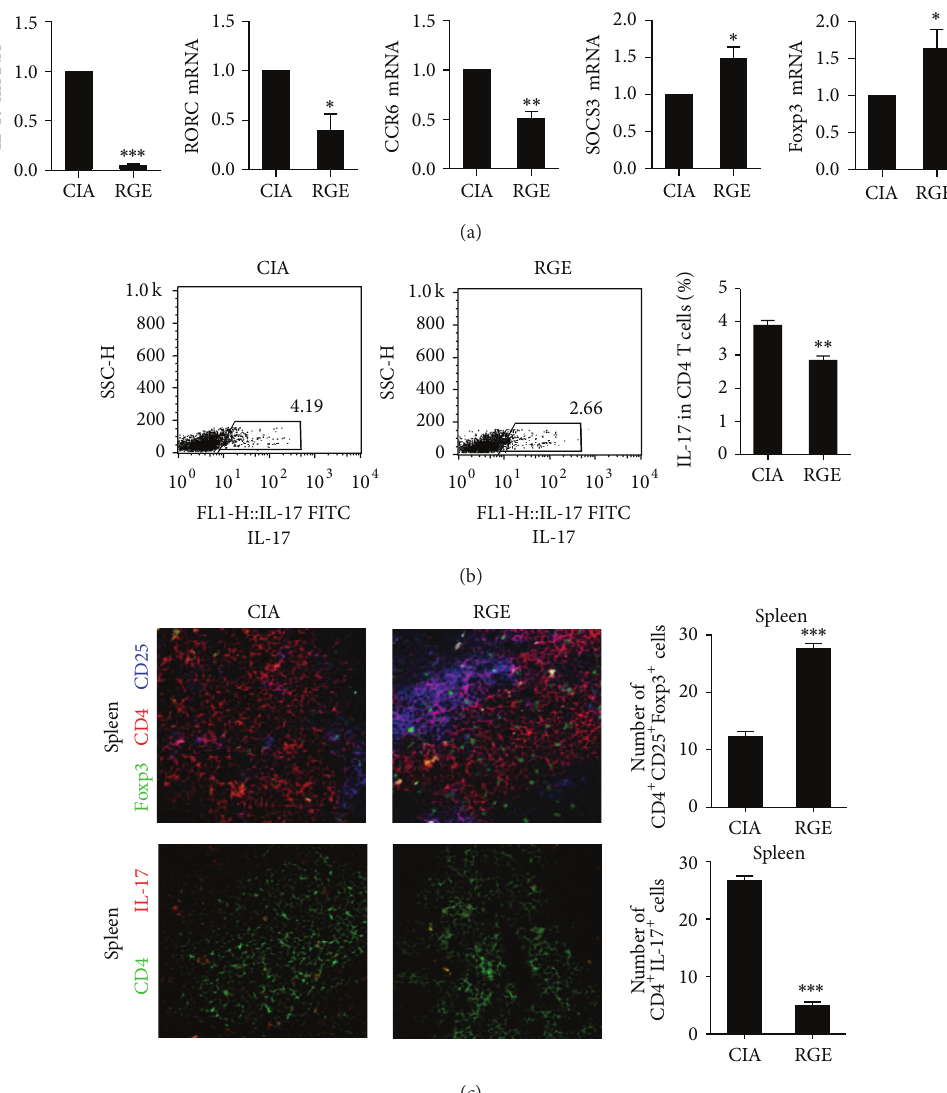
Figure 2: Red ginseng extract reciprocally modulates populations of regulatory T cells and Th17 cells in CIA mice. (a) Messenger RNA was isolated from splenocytes of either red ginseng extract (RGE) or vehicle-treated CIA mice. The mRNA expressions of Th17 cell-related molecules were measured by RT-PCR. (b) The proportion of IL-17-producing CD4 + T cells in the splenocytes was analyzed by flow cytometry. (c) Spleens were subjected to immunostaining for CD4 + CD25 + Foxp3 + or CD4 + IL-17 + cells. The number of cells was counted in four independent quadrants. Data are presented as the mean ± SD of three independent experiments ∗ 𝑃 < 0.05 , ∗∗ 𝑃 < 0.01 , and ∗∗∗ 𝑃 < 0.001 compared to control